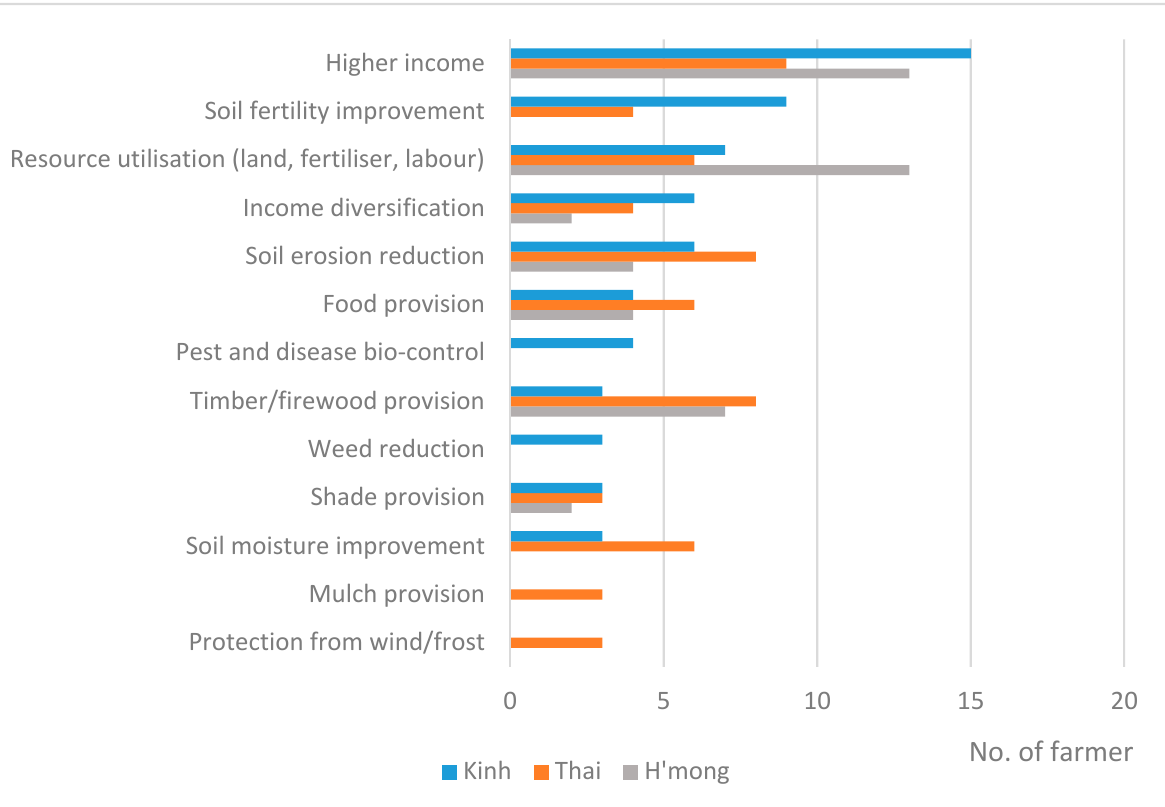
Figure 3. Absolute number of farmers from different ethnic groups mentioning different benefits that can be derived from agroforestry practices.